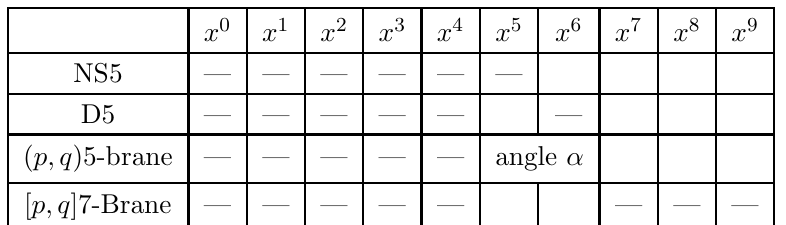
— — — Table 5 . Brane webs setup, where mark the spacetime directions spanned by the various branes − and tan( α ) = qτ 2 / ( p + qτ 1 ) where the axiodilaton is τ = τ 1 + iτ 2 . In this paper all the brane webs are drawn for the value τ = i , so that tan( α ) = q/p .